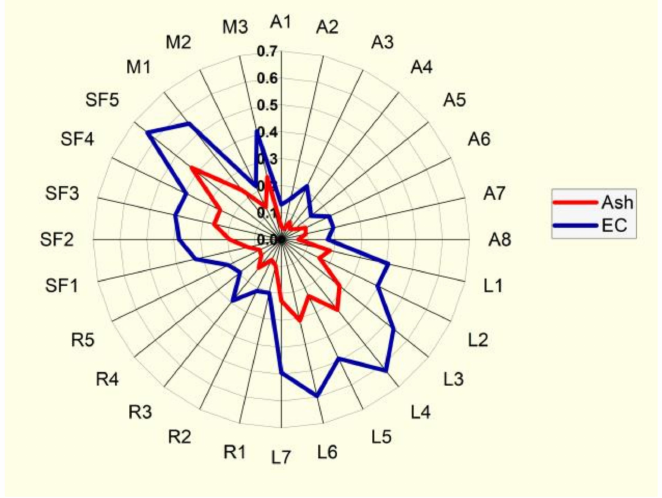
Figure 5. Radial graph of correlation between two parameters: ash content (%) and electrical conductivity (EC) (mS cm − 1 ).